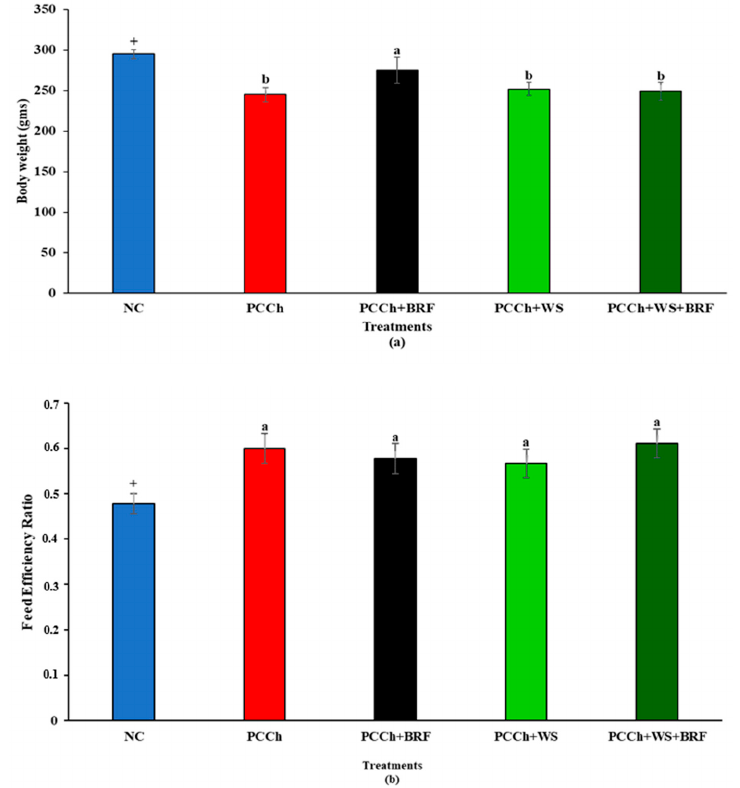
Figure 3. ( a ) Body weight gain of experimental rats. NC- AIN-76A diet. PCCh positive control (0.5% cholesterol, 0.05 cholic acid, 3% butter). BRF-black rice fraction. PCCh + BRF positive control with black rice fraction. PCCh + WS positive control with wood sterols. PCCh + WS + BRF positive control with wood sterols and black rice fraction. Bars represent means SEM / (n = 8). The + symbol signifies a significant di ff erence ( p < 0.05) between the negative cholesterol (NC) and positive control group (PCCh). Bars with di ff erent superscript letter (a,b) are significantly di ff erent ( p ≤ 0.05). ( b ). Fed e ffi ciency ratio of rats. NC- AIN-76A diet. PCCh positive control (0.5% cholesterol, 0.05 cholic acid, 3% butter). BRF-black rice fraction. PCCh + BRF positive control with black rice fraction. PCCh + WS positive control with wood sterols. PCCh + WS + BRF positive control with wood sterols and black rice fraction 1. Bars represent means SEM / (n = 8). The + symbol signifies a significant di ff erence ( P < 0.05) between the negative cholesterol (NC) and positive control group